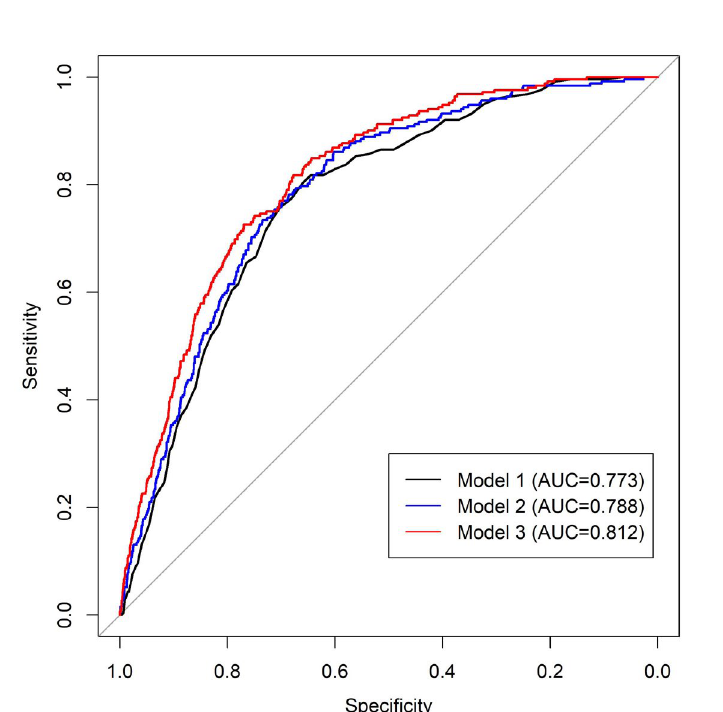
Figure 3. Receiver operating characteristic (ROC) curves of three models to predict incident dementia. Model 1: only included age and sex as the predictors of incident dementia; Model 2: included age, sex, segment length and number of segments as the predictors; Model 3: included age, sex, segment length, number of segments, and 14 acoustic features associated with incident dementia. The inclusion of segment information and acoustic features modestly improved the prediction performance with area under curve (AUC) increasing from 0.773 (model 1) to 0.788 (model 2) and 0.812 (model